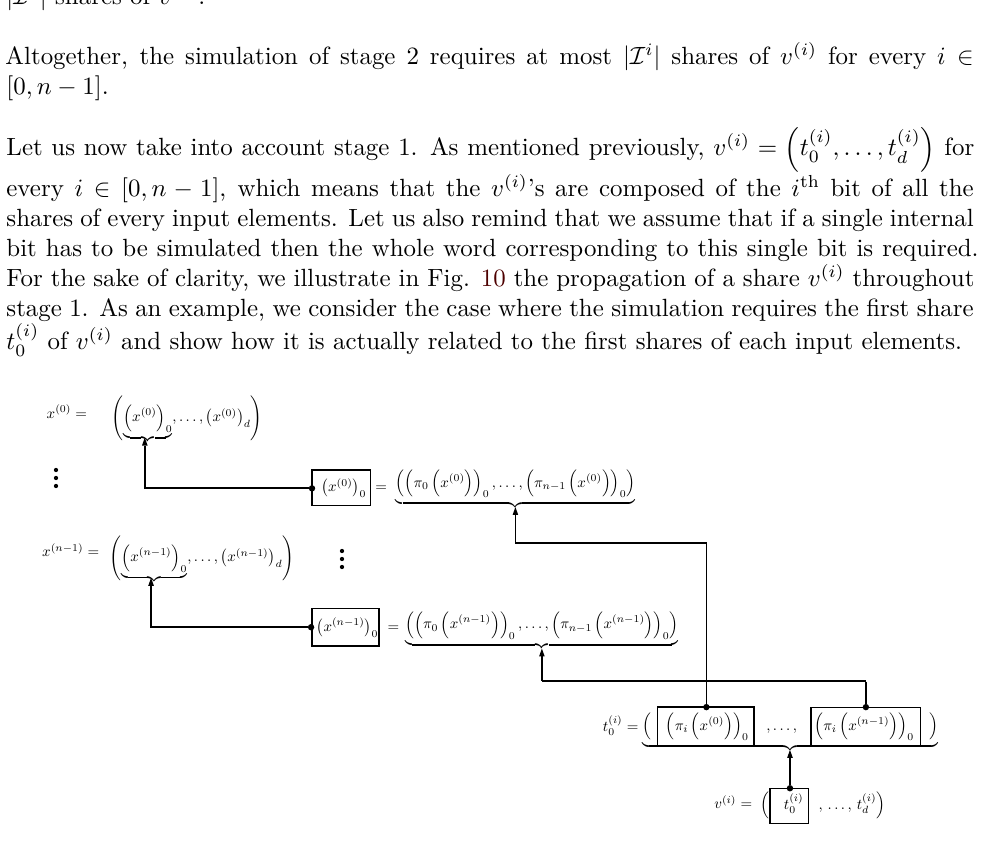
Figure 10: Linking the shares of the v i ’s to the shares of the input